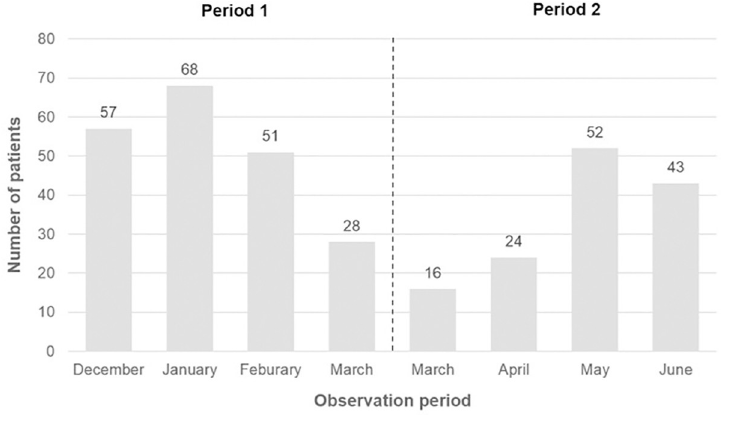
Fig 4. Patients discussed in weekly interdisciplinary tumor board.